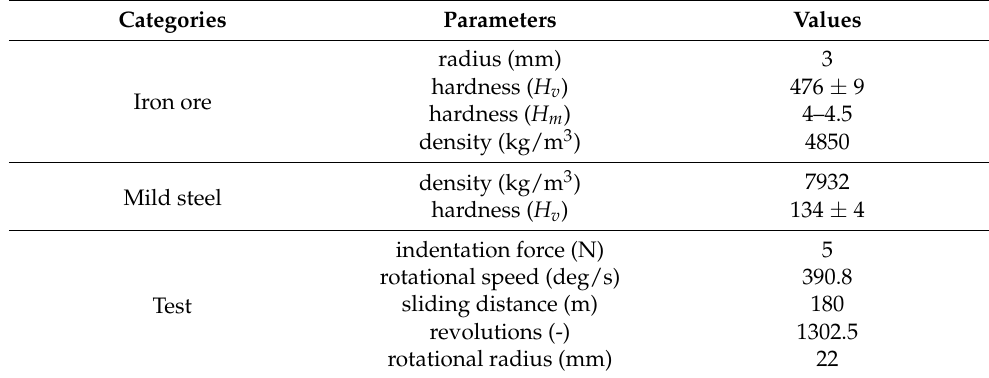
Table 1. Parameters of samples and